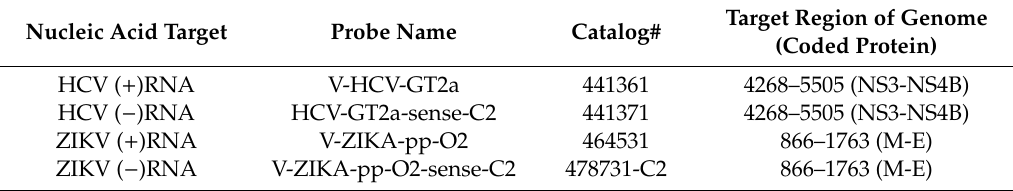
Table 1. Probes used in branched DNA fluorescence in situ hybridization (bDNA FISH). All probes were purchased from ACDBio. HCV, hepatitis C virus; ZIKV, Zika